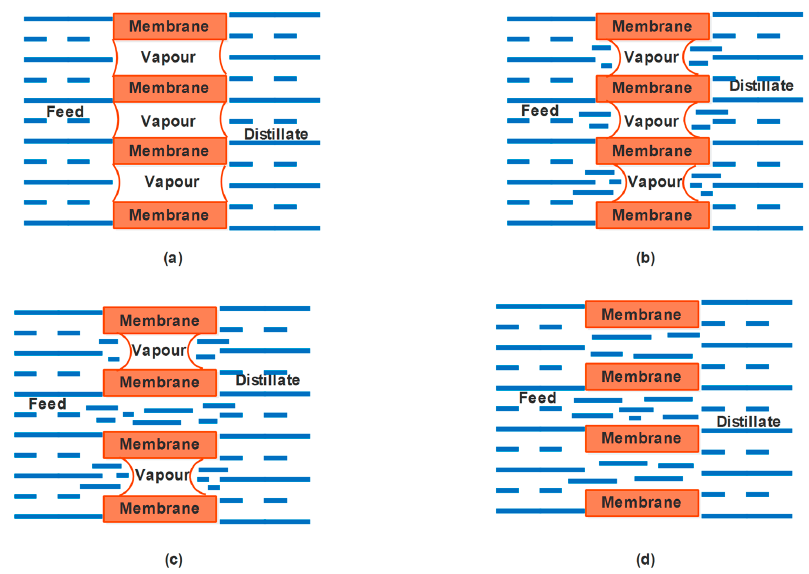
Figure 10. Schematic diagram of membrane wettability stages: ( a ) non ‐ wetted, ( b ) surface wetted, ( c ) partial wetted, and ( d ) fully wetted [35] .